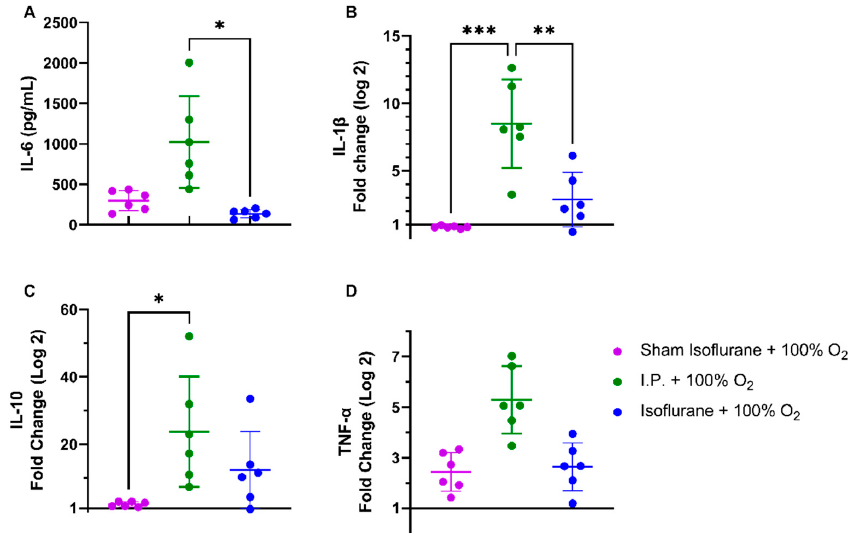
Figure 8. Isoflurane exerted anti-inflammatory changes on systemic IL-6 ( A ) and intestinal IL-1 β ( B ), IL-10 ( C ), and TNF- α ( D ). ( n = 6/group). IL: interleukin; I.P.: intraperitoneal injection anesthesia; O2: oxygen; TNF- α : tumor necrosis factor—alfa. * p < 0.05; ** p < 0.01; *** p < 0.001.